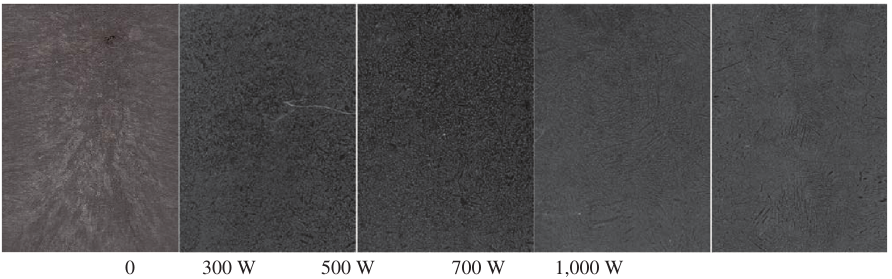
Figure 4: Macrostructure of GCr15 steel treated with different ultrasonic